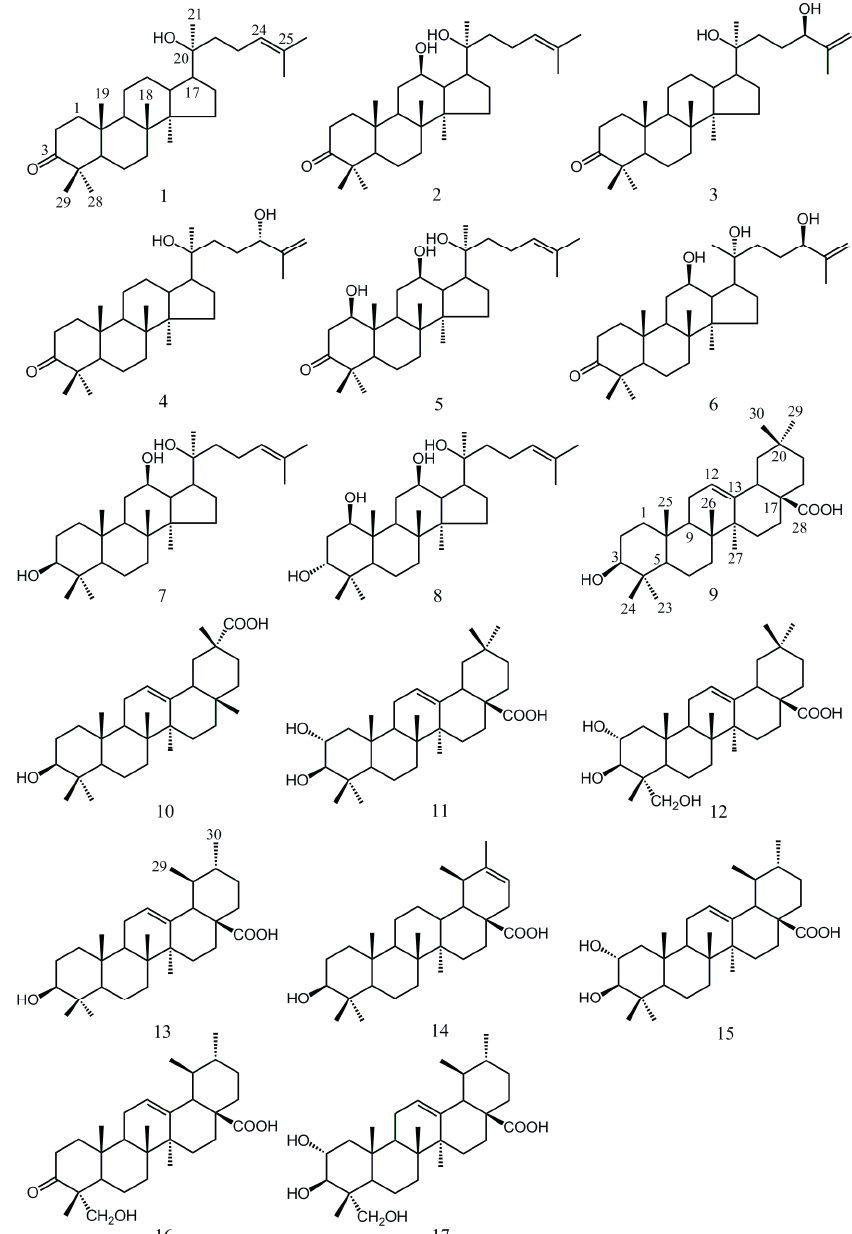
Figure 1. The chemical structures of compounds 1 – 17